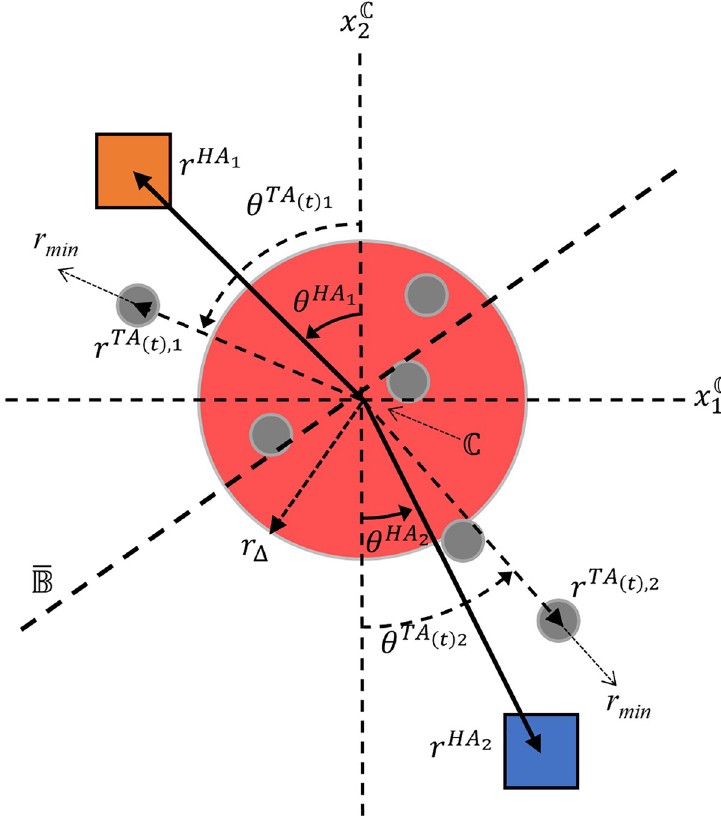
Fig 2. Pictorial representation of the task-space for human herding and containment. The position of the i th herding agent (HA ; where i = 1 [orange square], 2 [blue square]) is defined in a polar coordinate task-space i ( r HA i ; y HA i ) with the center of the containment region (the red circle), C , defined at the polar origin. At time t , each HA i moves towards the position of the TA, ( r TA ð t Þ ; i ; y TA ð t Þ i ), that is both i ) a member of the subset of TAs closer to itself than to its HA partner and ii ) is predicted to be the farthest TA in this subset from the center of the containment region at time at time t + Δ t . This subset can be visualized using the boundary � B � , defined as the perpendicular bisector ’s side of � B � comprise the set of potential targets for HA . of a line drawn between the HAs; the TAs falling on HA i i Parameter r min represent an offset to ensure TAs are repelled towards C , and r Δ represent a decision boundary that determines the minimum distance of the selected TA that elicits herding behaviors by an HA. See text for more details.